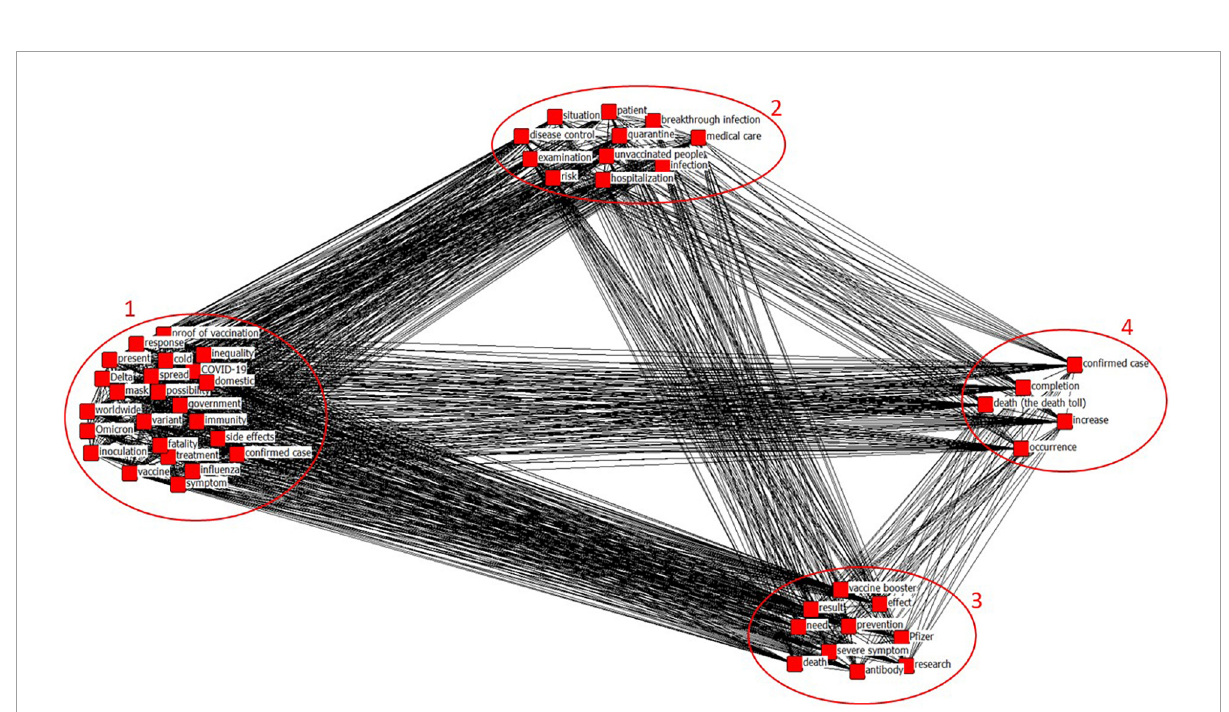
FIGURE7 Visualization of CONCOR analysis